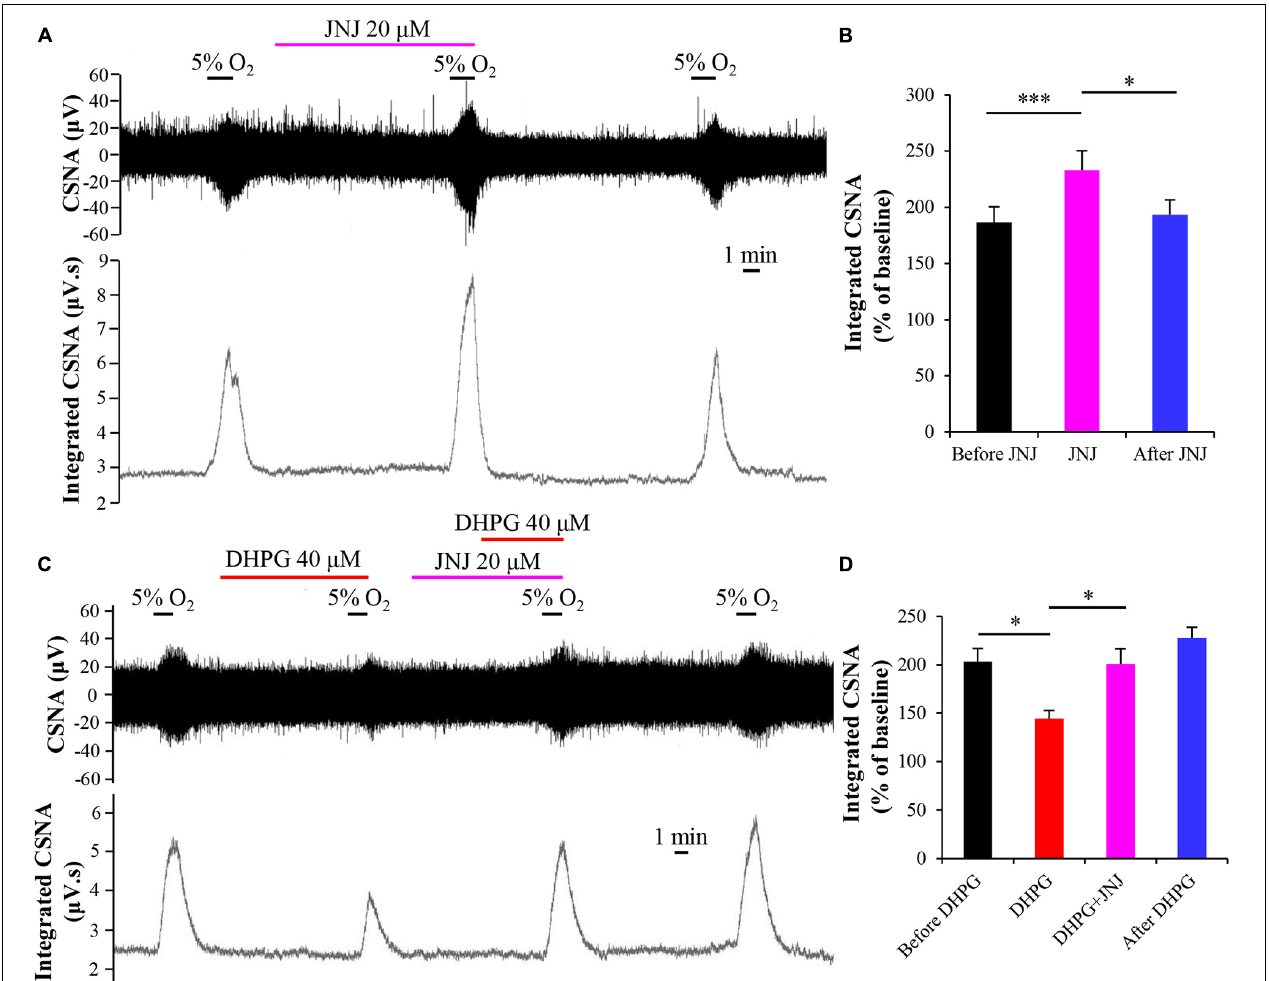
FIGURE 5 | mGluR1 antagonist JNJ blocks the inhibitory effect of DHPG on CB response to hypoxia. (A) Effect of JNJ (20 µ M) on the CSNA under hypoxia conditions. Note that DHPG reversibly enhances the CSNA under hypoxia conditions. (B) JNJ (20 µ M) increases the normalized integrated CSNA during hypoxia. n = 7. (C,D) Pretreatment with JNJ prevents the inhibitory effect of DHPG on CB response to hypoxia. The data were presented as mean ± SEM. n = 4. ∗ p < 0.05 and ∗∗∗ p < 0.05 indicate significant difference (one-way ANOVA with repeated measures). CSNA, carotid sinus nerve activity; JNJ, JNJ16259685, mGluR1